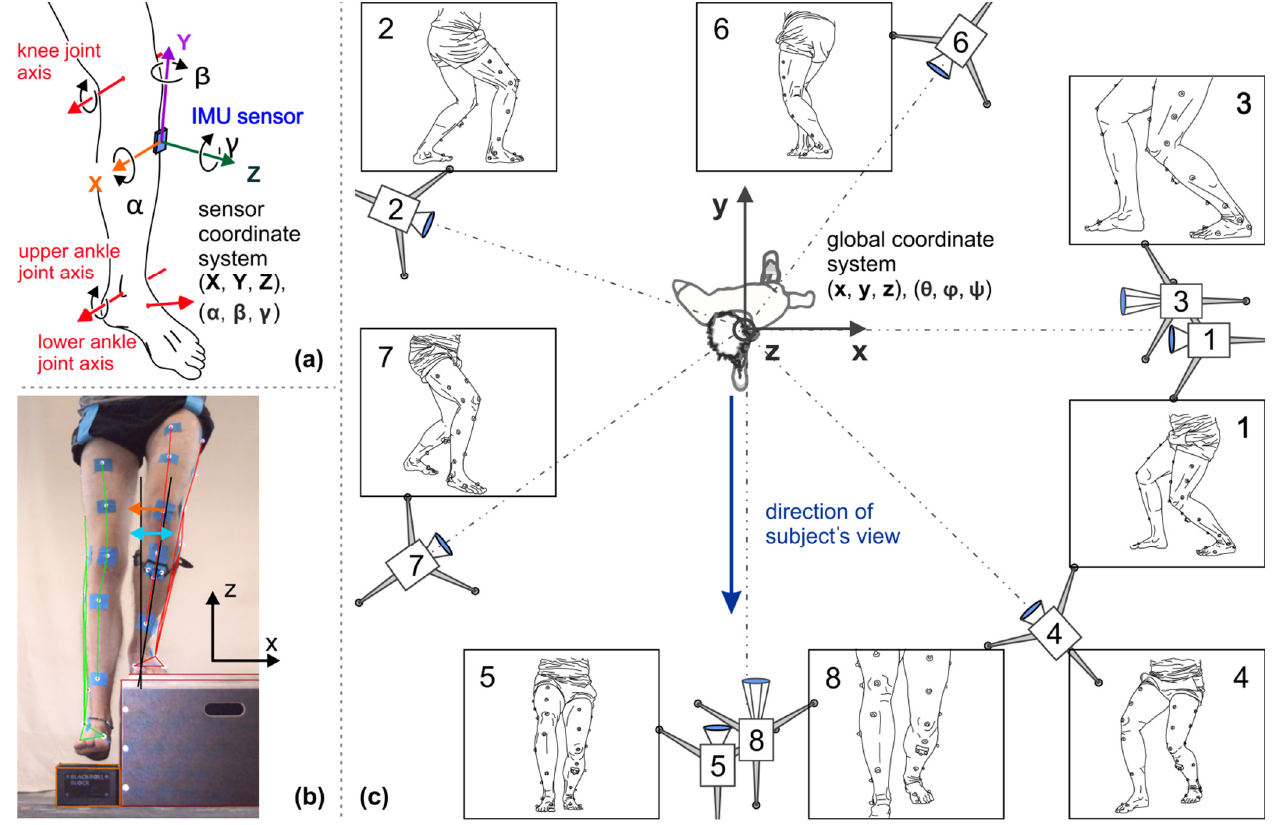
Figure 1. ( a ) Axis systems of the lower leg and IMU sensor. ( b ) Video image from camera 5: light-reflecting markers in extended standard marker setup for motion Test 6 One-Leg Squat. ( c ) Ar- rangement of the 8 cameras of the video-MA: top view, not exactly scaled; zoom cameras 3 and 8 for close-up; camera images show Test 2 Ankle